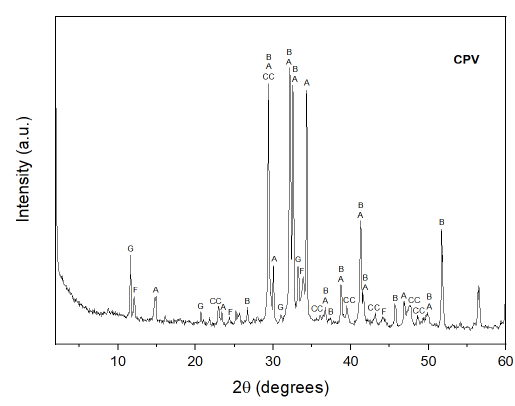
Figure 1. X-ray diffractogram of the Portland cement (CP V). G-gypsum, F-ferrite, A-alite, CC-calcite,